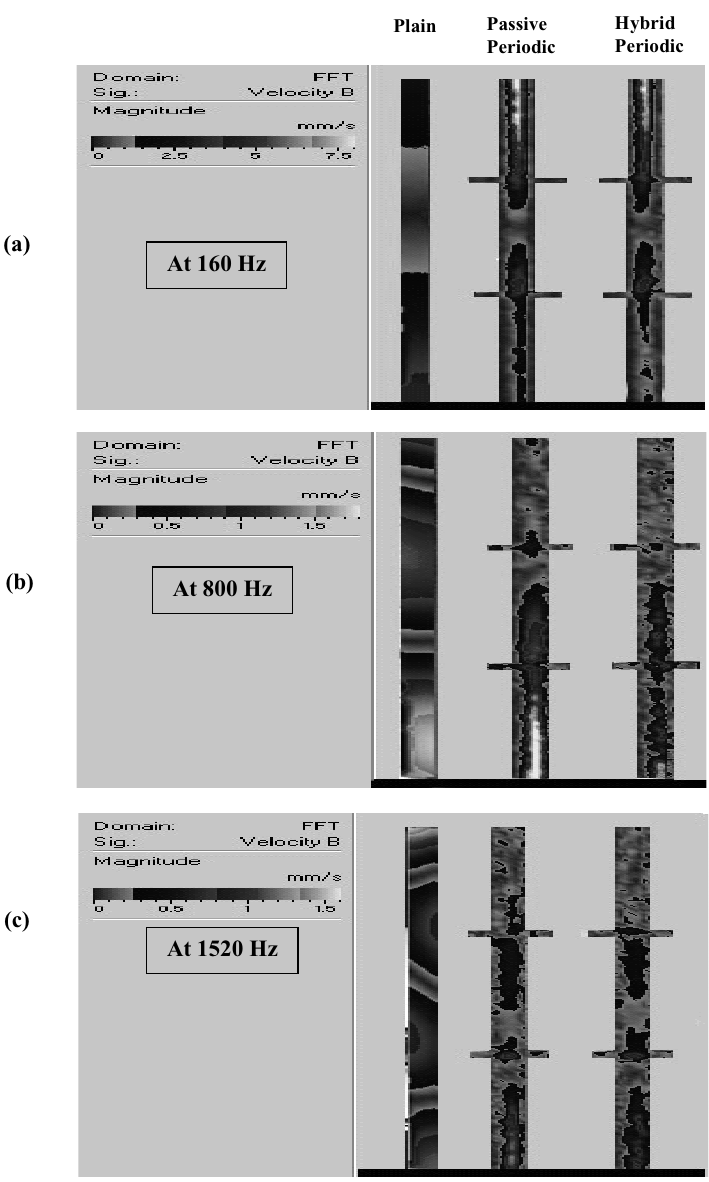
Fig. 12. The vibration of plain, passive periodic and hybrid periodic rods